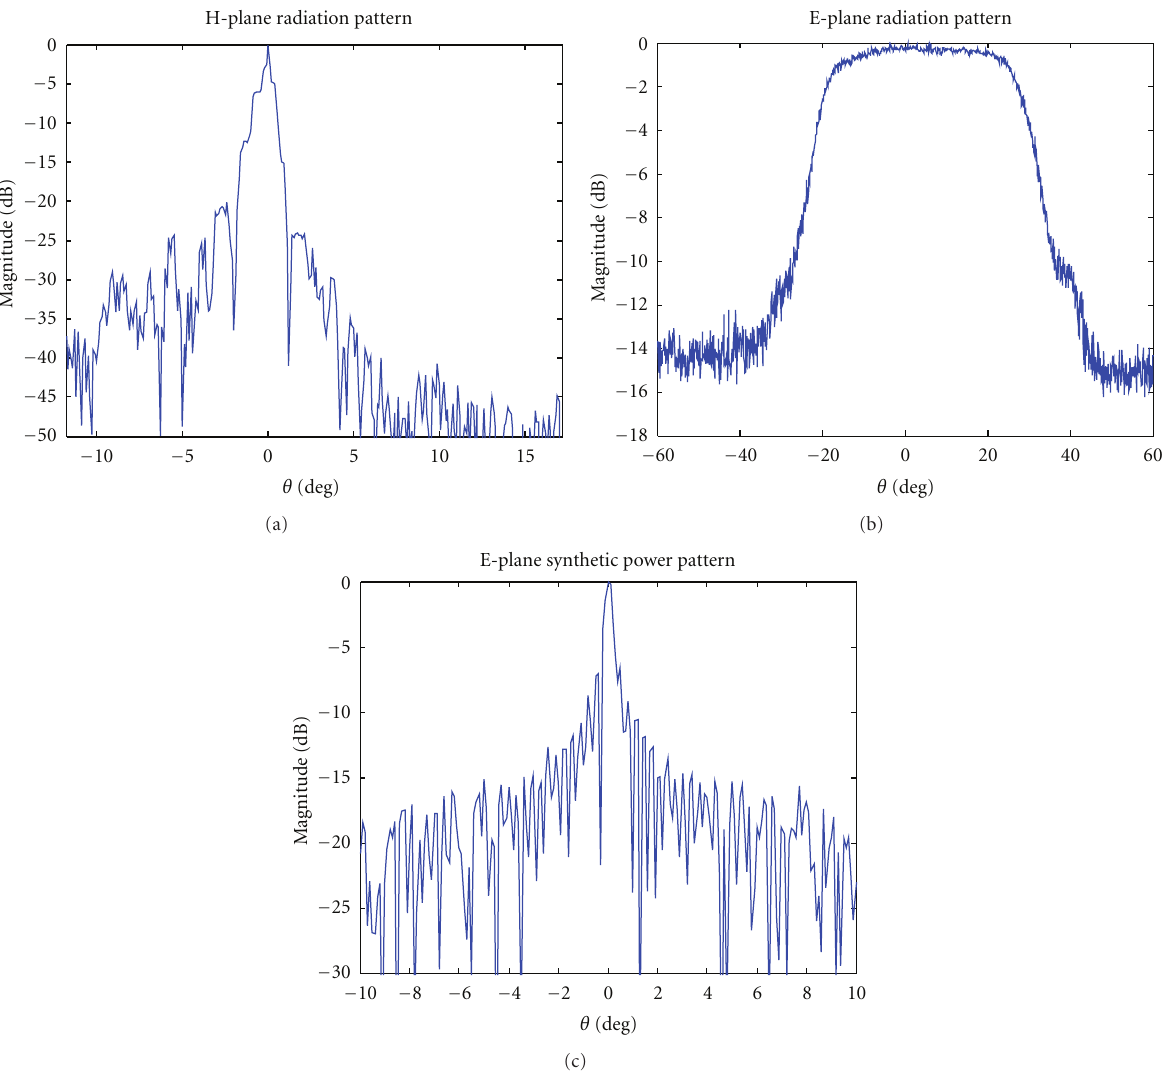
Figure 3: The measured HUST-ASR antenna pattern: (a) the H-plane pattern of an “element”; (b) the E-plane pattern of an “element”; (c) the synthesized E-plane pattern of all the “elements” by interferometric aperture synthesis.